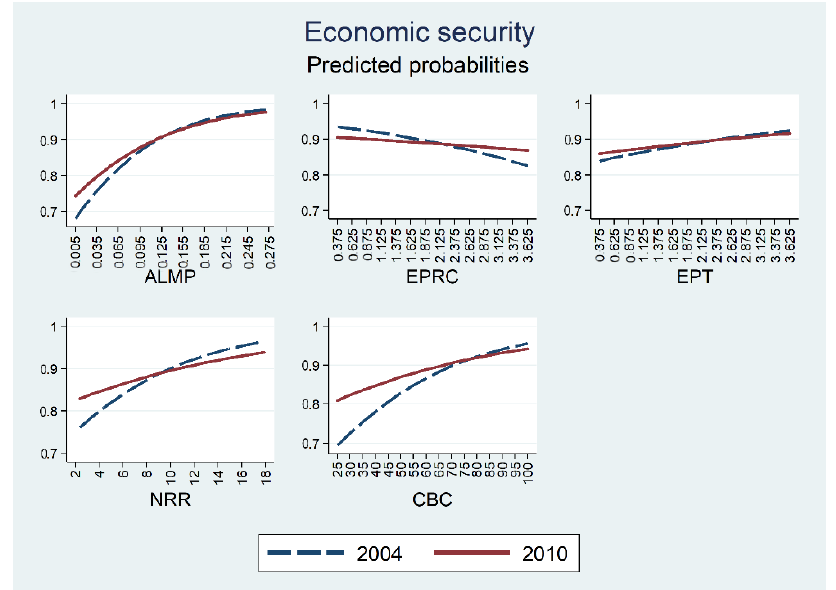
Figure 4. Institutions, economic security, and the crisis. Source: Pooled data from the second and fifth waves of the European Social Survey. Notes: (1) For EPRC and EPT, the sample includes only temporary workers. (2) Predicted probabilities were plotted with the full set of controls. All control variables are set to their mean. (3) Likelihood ratio tests (Prob > Chi 2 ) for whether the interaction effect is statistically significant: ALMP = 0.00; EPRC = 0.00; EPT = 0.06; NRR = 0.00; CBC = 0.00. Confidence intervals are available upon request.